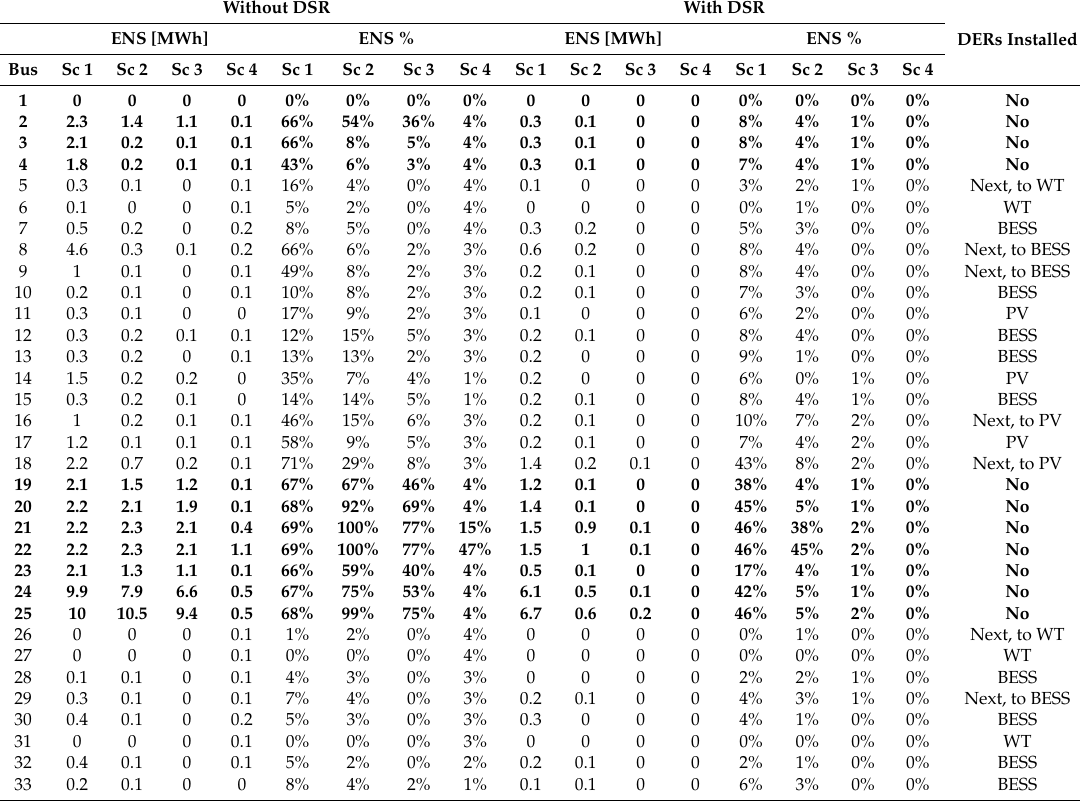
Table 3. Energy not supplied and its percentage of